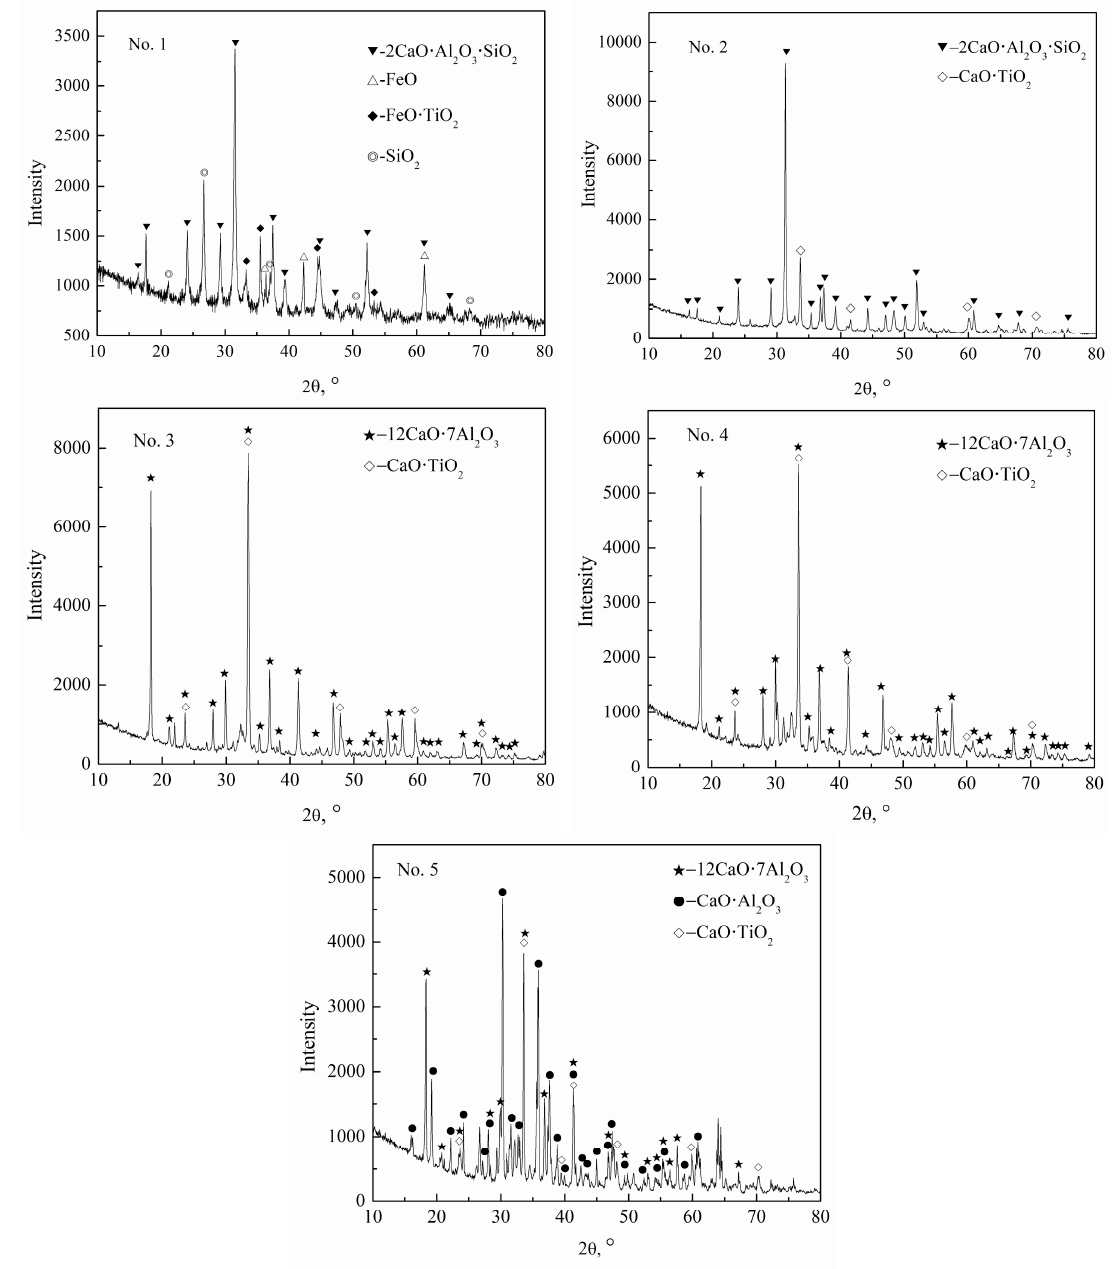
Figure 9. XRD analysis of the smelting separation slags including No. 1 slag, No. 2 slag, No. 3 slag, No. 4 slag, and No. 5 slag.